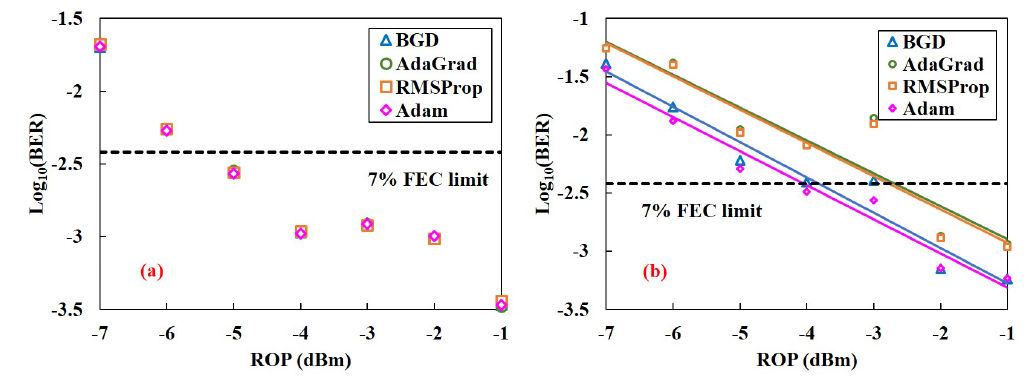
Figure 4. BER performance of 129-Gbit/s PAM8 system versus ROPs at BTB ( a ) and 2-km transmission ( b ) with FFE, post filter, and MLSD. FFE employs BGD (blue triangle), AdaGrad (green rhombus), RMSProp (orange square) and Adam (purple circle),